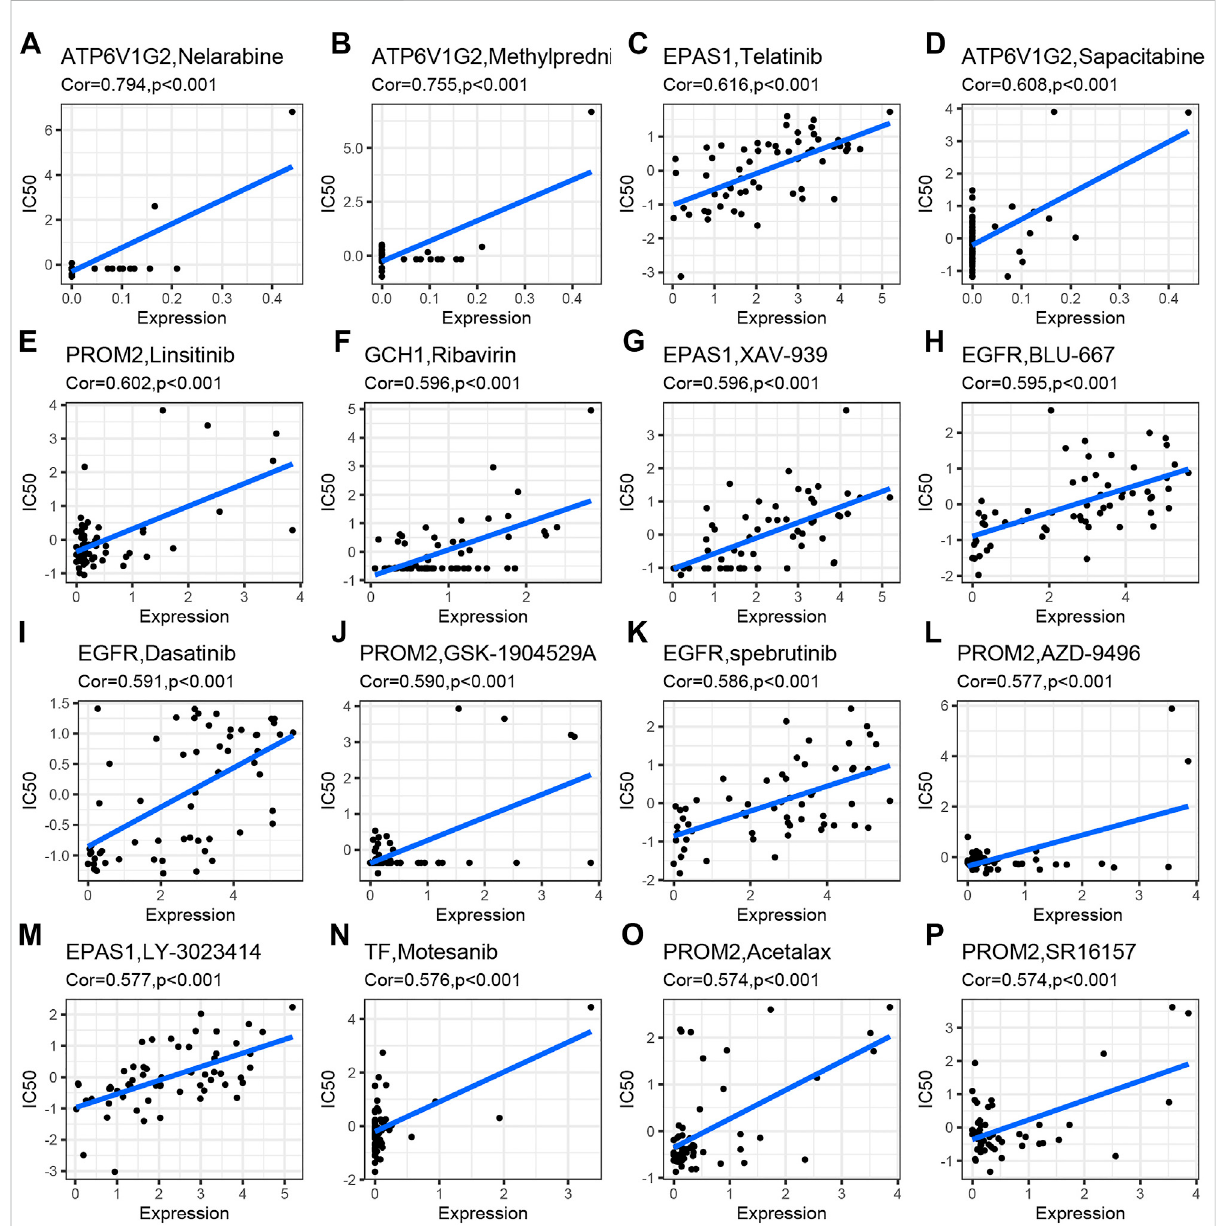
FIGURE 7 Drug sensitivity analysis of differentially expressed and survival-related FRGs. Drug sensitivities of Nelarabine (A) , Methylprednisolone (B) , and Sapacitabine (D) werepositivelyrelatedto ATP6V1G2 expression.DrugsensitivitiesofTelatinib (C) ,XAV-939 (G), andLY-3023414 (M) werepositively relatedtoEPAS1expression.DrugsensitivitiesofLinsitinib (E) ,GSK-1904529A (J) ,AZD-9496 (L) ,Acetalax (O), andSR16157 (P) werepositivelyrelated to PROM2 expression. Drug sensitivity of Ribavirin (F) was positively related to GCH1 expression. Drug sensitivities of BLU-667 (H) , Dasatinib (I), and spebrutinib (K) were positively related to EGFR expression. Drug sensitivity of Motesanib (N) was positively related to TF